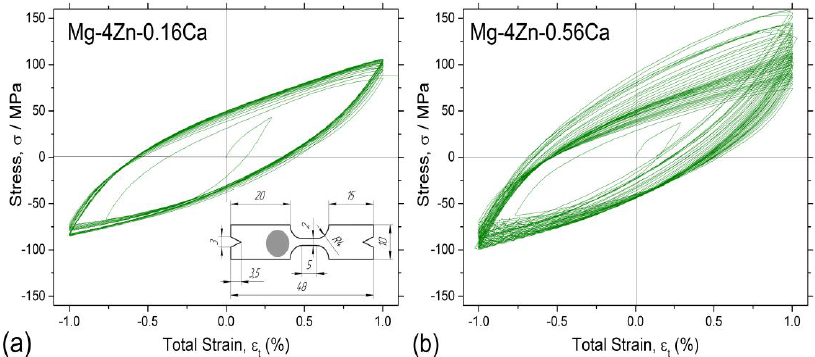
Figure 3. Hysteresis loops in the ZX40 specimens Mg-4Zn-0.16Ca ( a ); and Mg-4Zn-0.56Ca ( b ) during cyclic deformation under total strain control with the total strain amplitude Δε t /2 = 1 × 10 −2 . The specimen shape and geometry is shown in the inset. The circle indicates the location of the acoustic emision sensor.